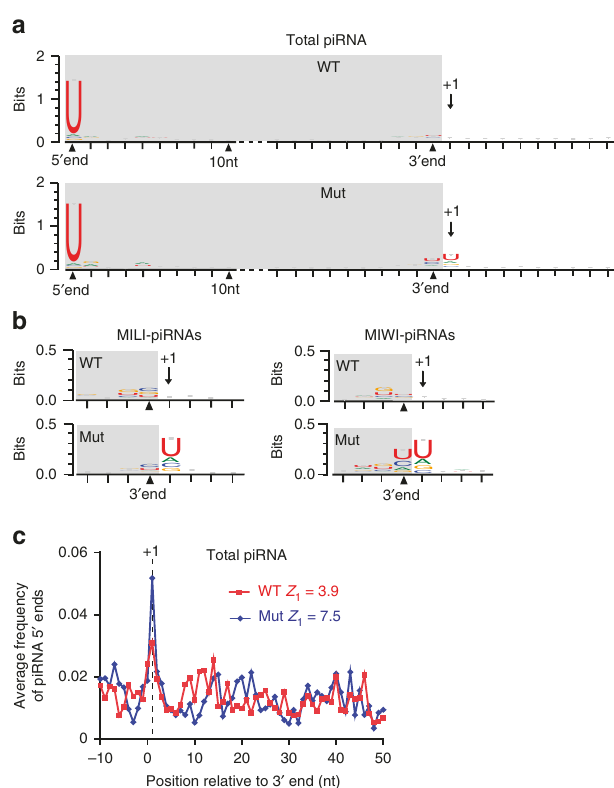
Fig. 6 Pachytene piRNA biogenesis is phased in mice. a U bias at position +1 downstream of piRNA 3 ′ ends in Pnldc1 Mut total piRNA. The 24 – 48 nt reads from WT and Pnldc1 Mut (Mut-1) total piRNA libraries were mapped to one representative pachytene piRNA cluster (2-qE1-35981.1, the most abundantly expressed). Sequence logos showing nucleotide composition at mapped piRNA 5 ′ ends, 3 ′ ends, and downstream regions of 3 ′ ends were generated. Gray shading marks the piRNA region. b U bias at position +1 downstream of piRNA 3 ′ end in Pnldc1 Mut MILI-piRNAs and MIWI-piRNAs. The 24 – 48 nt reads from WT and Pnldc1 Mut (Mut-1) MILI- and MIWI-piRNA libraries were mapped to one representative pachytene piRNA cluster (2-qE1-35981.1). Sequence logos showing nucleotide composition in the vicinity of mapped piRNA 3 ′ ends were generated. Gray shading marks the piRNA region. c Untrimmed Pnldc1 Mut piRNAs exhibit coupling of piRNA 3 ′ ends with subsequent piRNA 5 ′ ends. The 24 – 48 nt reads from WT and Pnldc1 Mut (Mut-1) total piRNA libraries were mapped to one representative pachytene piRNA cluster (2-qE1-35981.1). Top 1000 distinctively mapped piRNAs were extracted as references to perform 3 ′ – 5 ′ coupling analysis. The frequency of piRNA 5 ′ ends around referenced piRNA 3 ′ ends was calculated. Z -scores at position +1 ( Z 1) are